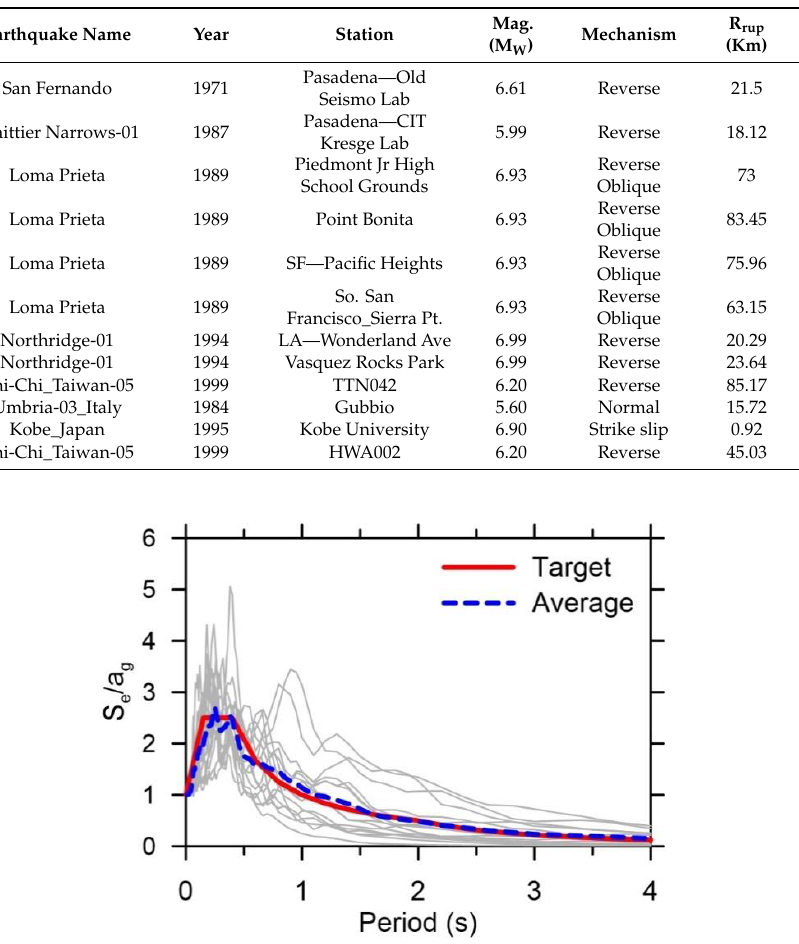
Figure 6. Comparison of selected input ground motions with the target spectrum.